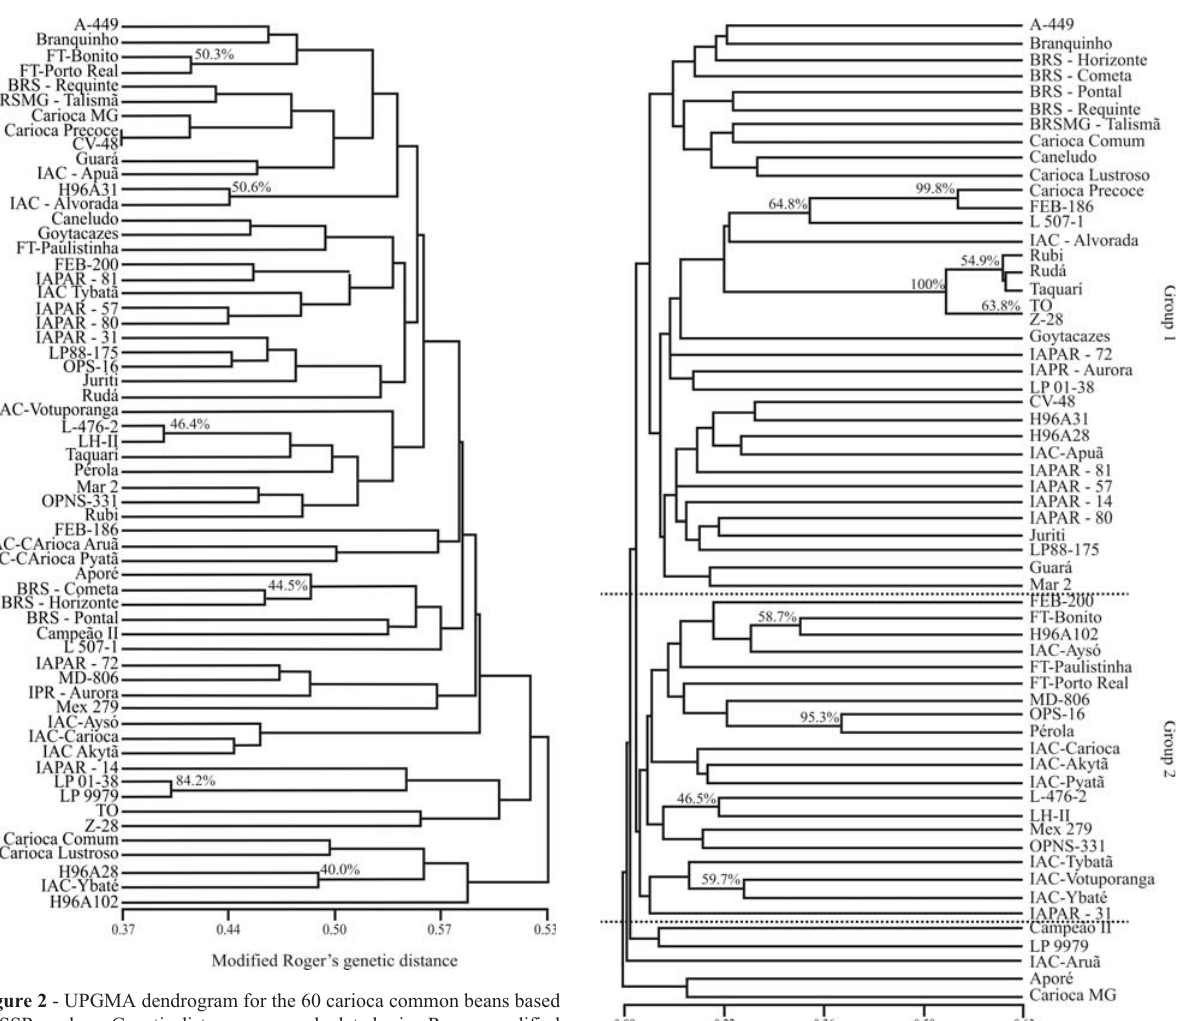
Figure 2 - UPGMA dendrogram for the 60 carioca common beans based onSSRmarkers.GeneticdistanceswerecalculatedusingRogersmodified genetic distance.